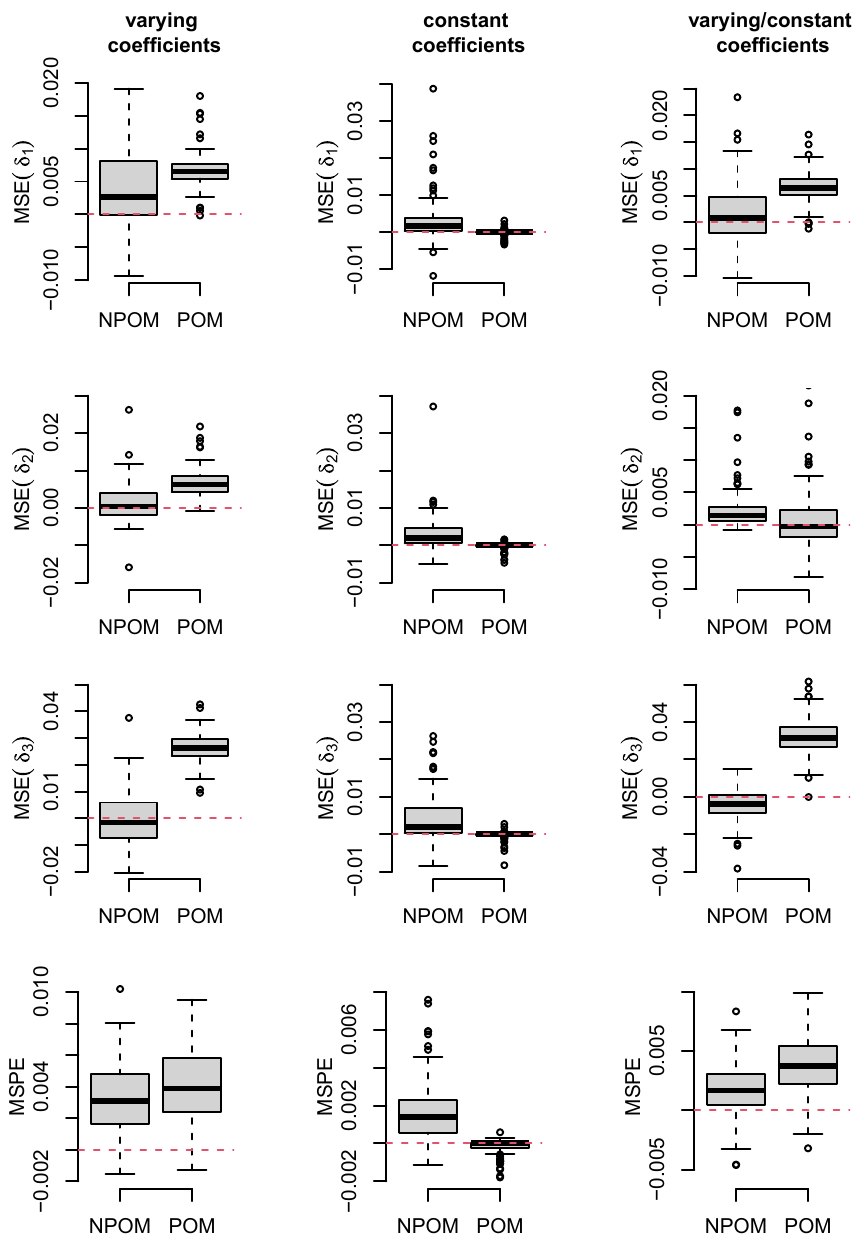
Figure 5. The pairwise differences of SERP and (N)POM across simulation runs with respect to the MSE (rows 1–3) of the slope parameter estimates and the MSPE (last row), given three different simulation settings (column-wise): (1) varying coefficients, (2) constant coefficients, and (3) varying and constant coefficients. The horizontal dashed lines indicate the mark of SERP’s improvement over (N)POM, with differences above the dashed lines indicating better performance with